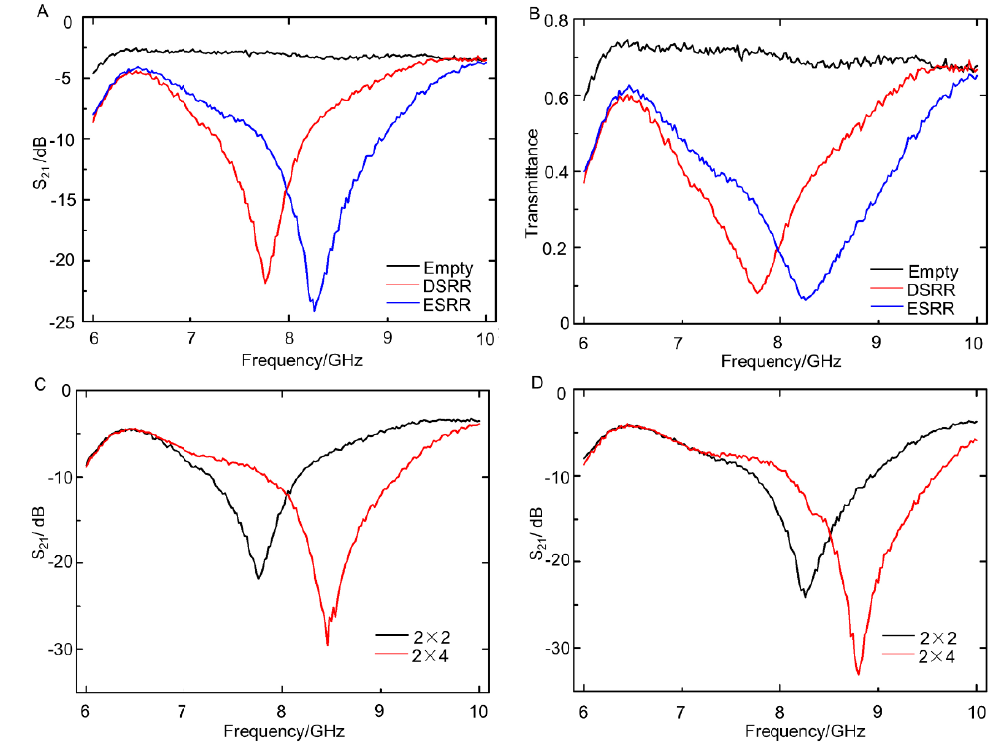
Figure 5. Electromagnetic properties of metamaterials based on SRR arrays: ( A ) the S 21 parameter of metamaterials with different structures; ( B ) the transmittance curve of metamaterials with different structures; ( C ) the S 21 parameter of DSRR-based metamaterials composed of different arrays; ( D ) the S 21 parameter of ESRR-based metamaterials composed of different arrays.